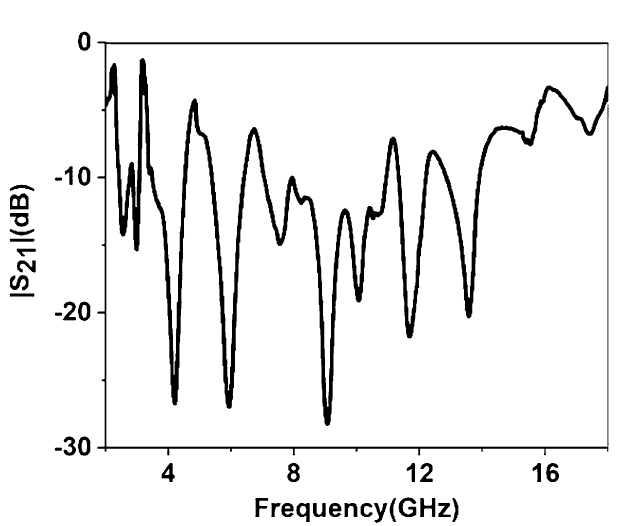
Figure 29. Measured |S 21 | for 35 × 25 array.